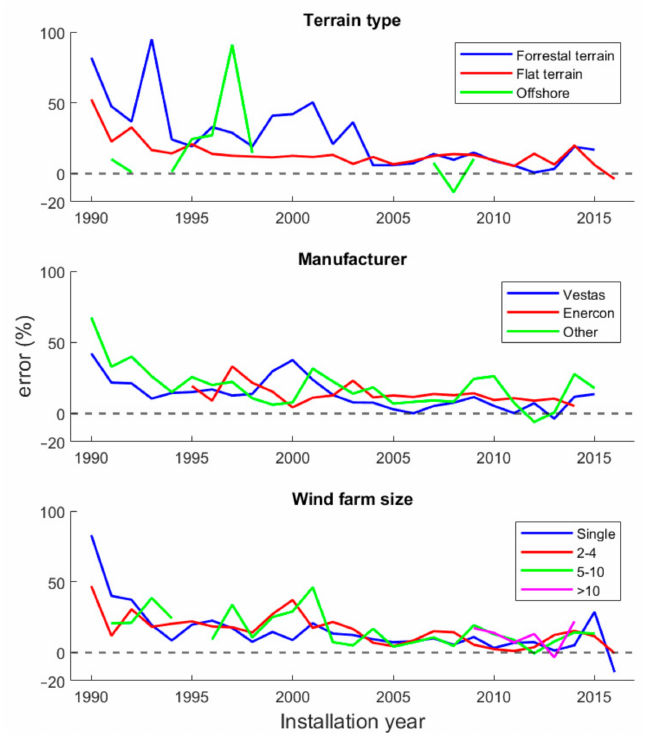
Figure 5. The time development of the AEP prediction accuracy divided on terrain type, manufac- turer, and wind farm